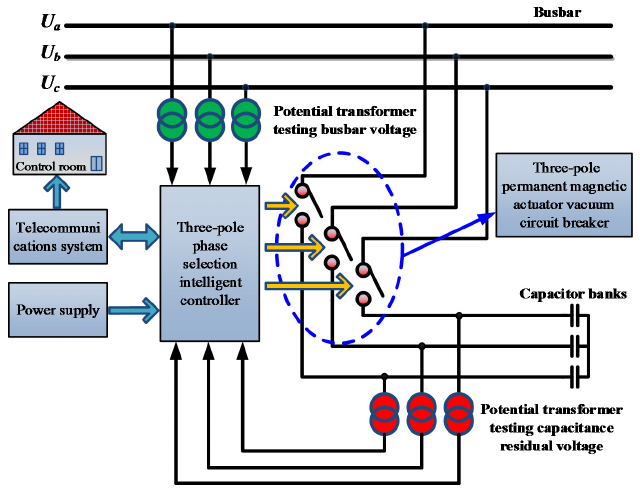
Figure 3. Structure chart of phase ‐ controlled VCBs (MDS2B ‐ 12).